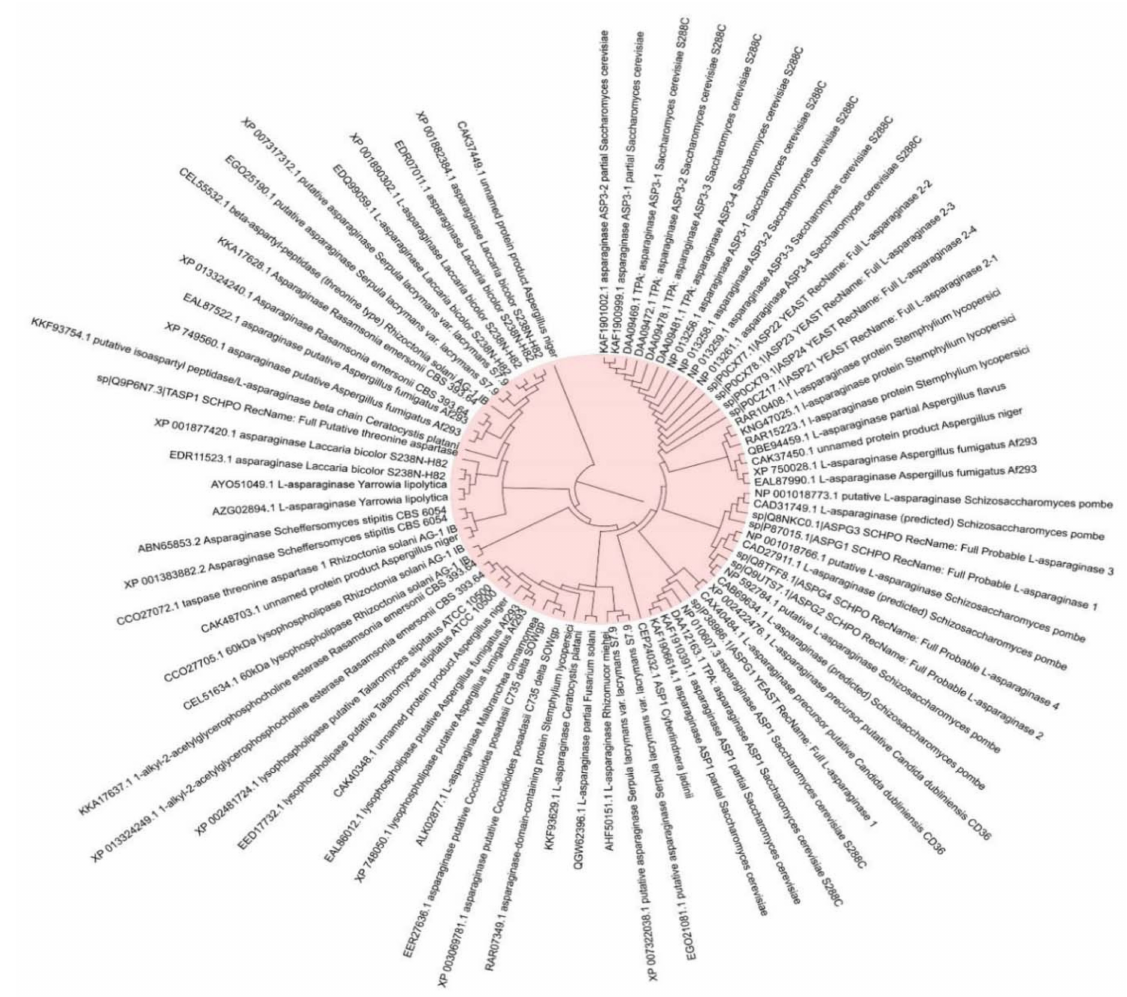
Figure 6. The most common fungal strains with high production of